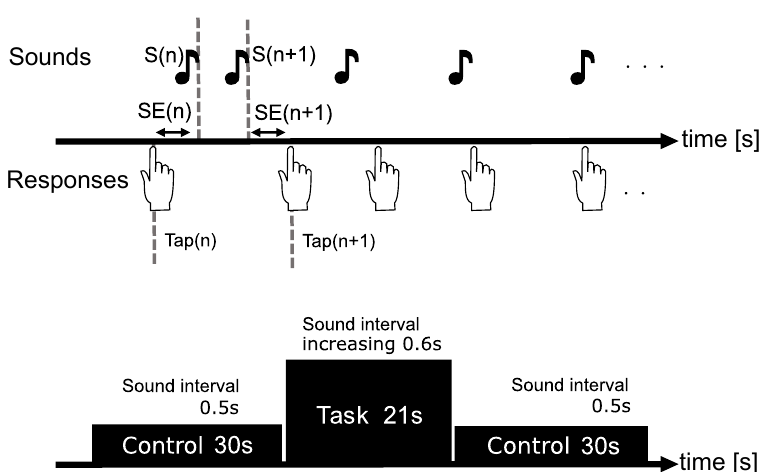
Figure 1. A block design consisting of two controls and one task block. A synchronous tapping task was used, and the subjects were required to respond to the sound stimulus presented at regular time intervals. In the control phase, the sound interval was 0.5 s ( S ( n + 1 ) − S ( n ) = 0.5 s), while, in the task phase, the sound intervals were regularly increased ( S ( n + 2 ) = S ( n + 1 ) − S ( n ) + 0.6 ± 0.03